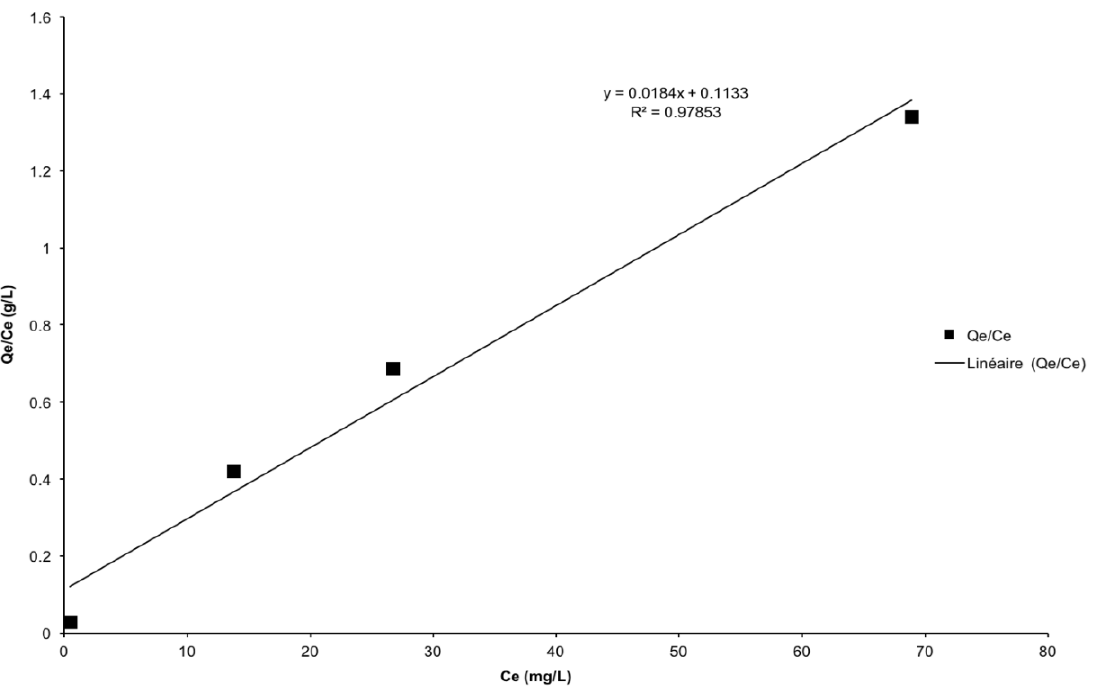
Figure 9. Plots of adsorption of MB onto the PEGCD2 polymer following the Langmuir model. All the parameters for the Langmuir model for EGCD, PEGCD1 and PEGCD2 are listed in Table 2. Table 2. Adsorption isotherm parameters for MB adsorption.